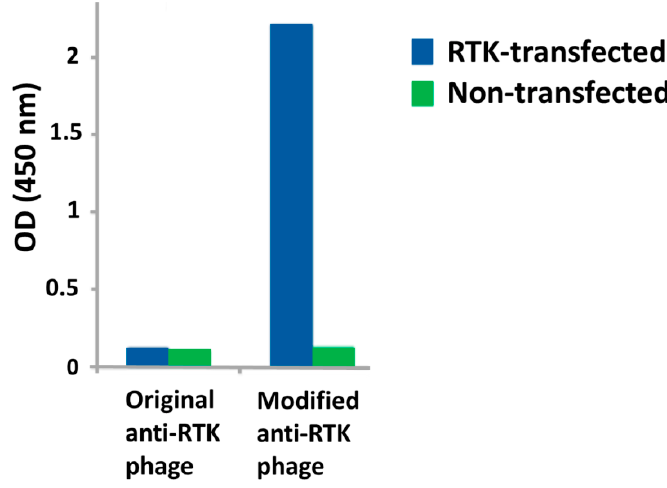
Figure 6. Cell enzyme-linked immunosorbent assay (ELISA) sensitivity using monovalent versus multivalent phage display system against transiently transfected cells. Human embryonic kidney 293 (HEK-293) cells were transiently transfected with an expression construct for a receptor tyrosine kinase (RTK). Phage displaying a scFv specific for the RTK was produced using either a standard helper phage (M13K07) or a modified helper phage (hyperphage) for monovalent or multivalent display of the scFv on the M13 virion, respectively. The phage produced using the monovalent display system showed no binding to the transfected cells in a cell ELISA. In contrast, the phage produced using the multivalent display system showed a dramatic increase in binding to the RTK-expressing